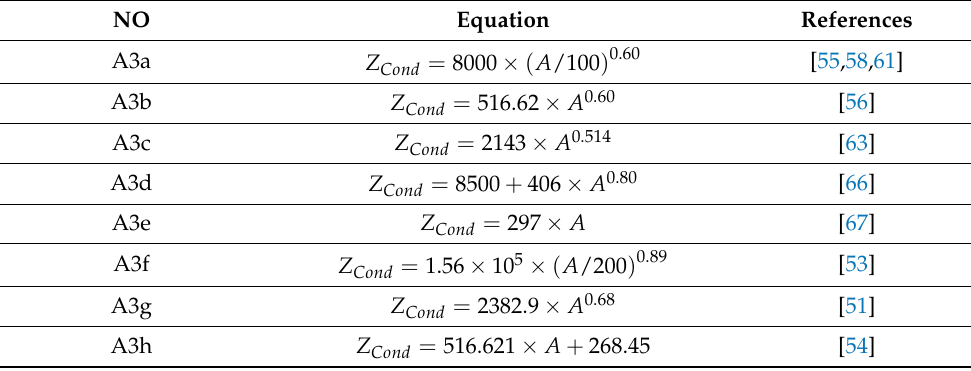
Table A3. Condenser purchasing cost